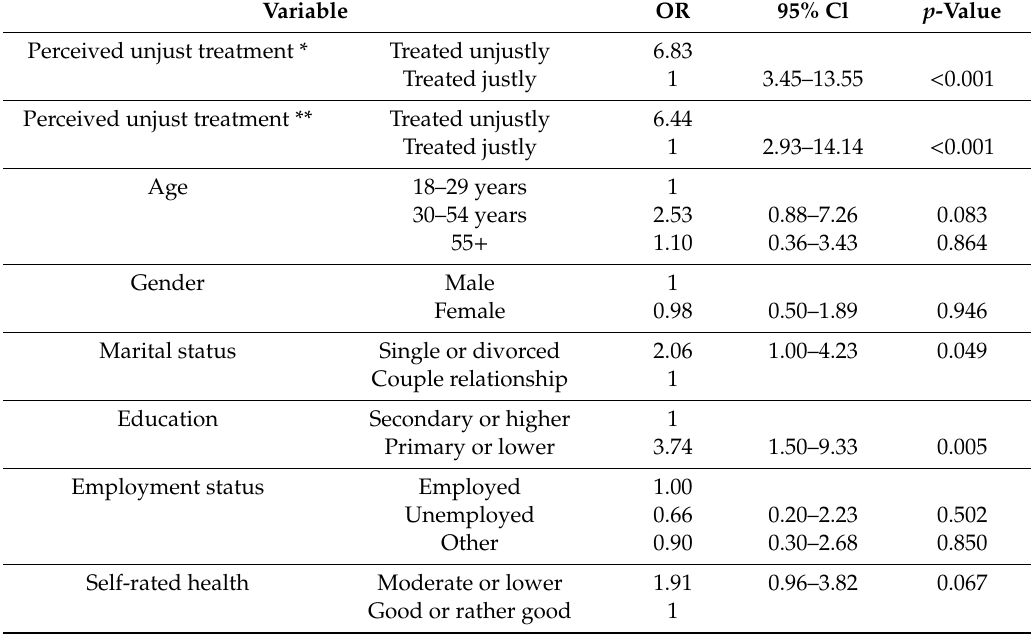
Table 3. The association between the perceived unjust treatment and the unmet need for GPs, %, 95% CI and p -value. The results are adjusted for age, gender, marital status, education, employment status, and self-rated health